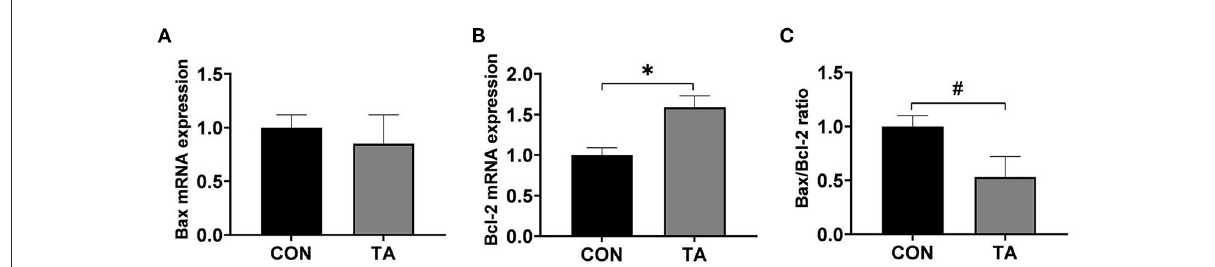
FIGURE6 Effects of dietary supplemented with microencapsulated TA from Galla Chinensis on apoptosis-related genes in live of broiler chickens. (A) BCL2-Associated X (Bax), (B) B-cell lymphoma-2 (Bcl-2), (C) Bax/Bcl-2 ratio. CON, broiler chickens fed a basal diet; TA, broiler chickens fed a basal diet supplemented with 300 mg/kg microencapsulated TA from Galla Chinensis . Values are mean ± standard error ( n = 6). * P < 0.05, # 0.05 < P <